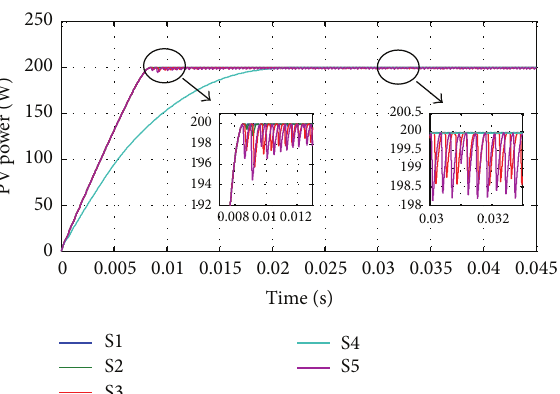
0.02 Ω , the output capacitance, 𝐶 resistance, 𝑅 , is 20 Ω . The switching frequency of the system is 25 kHz.